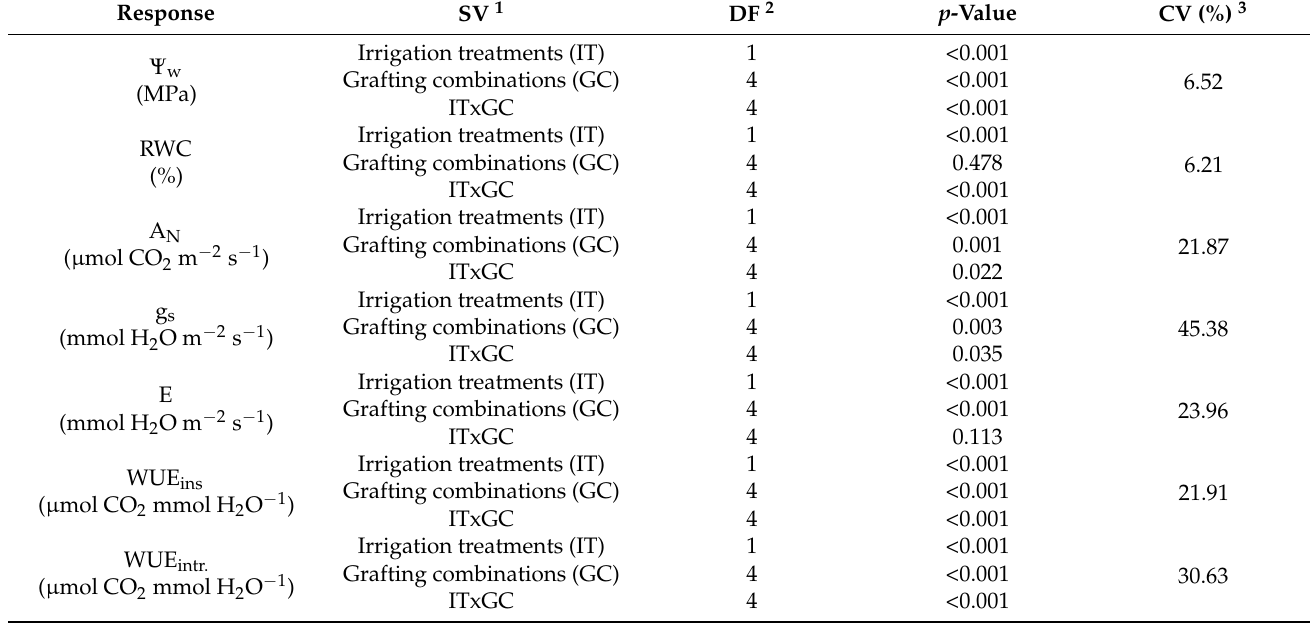
Table 1. Summary of the two-way analysis of variance with p -values for the effects of irrigation treatments (IT), grafting combinations (GC), and ITxGC interactions on water potential ( Ψ w ), relative water content (RWC), net photosynthetic rate (A N ), stomatal conductance (g s ), leaf transpiration rate (E), instantaneous leaf water use efficiency (WUE ins ), intrinsic leaf water use efficiency (WUE intr ), malondialdehyde (MDA), proline, histidine, arginine, glutamine, and valine. Response SV 1 DF